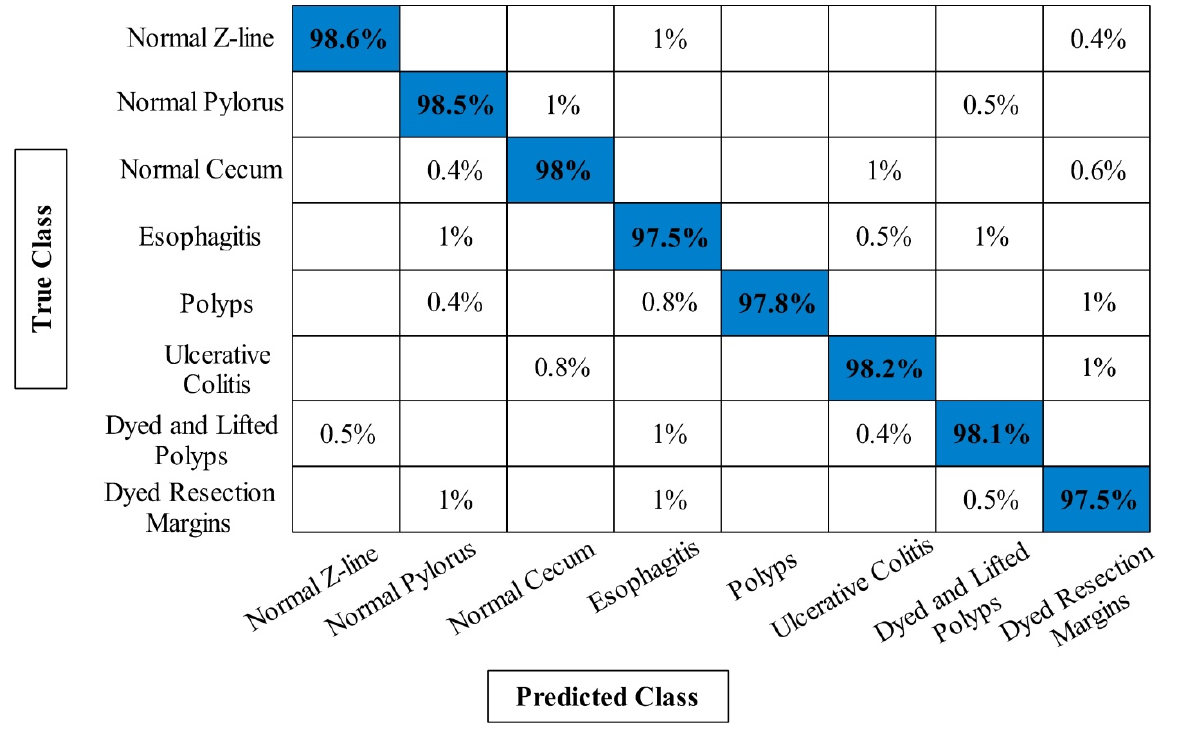
Figure 10. Confusion matrix of proposed framework for ELM classifier on Kvasir V2 dataset.